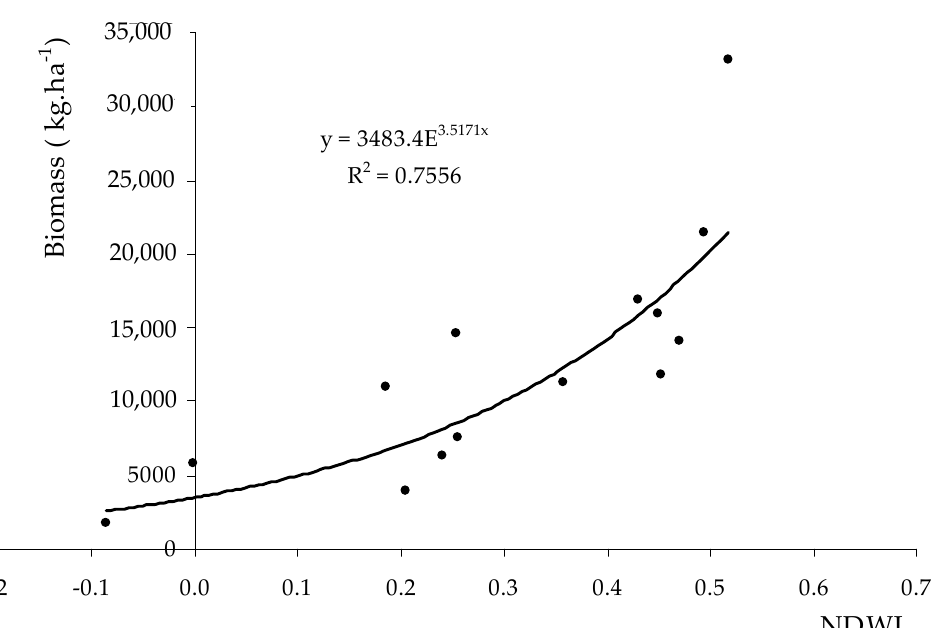
Figure 12. Relationship between normalized difference water index (NDWI) and pasture biomass, over sampling times (springs 2016–2018). Data are average values of 12 sampling points.